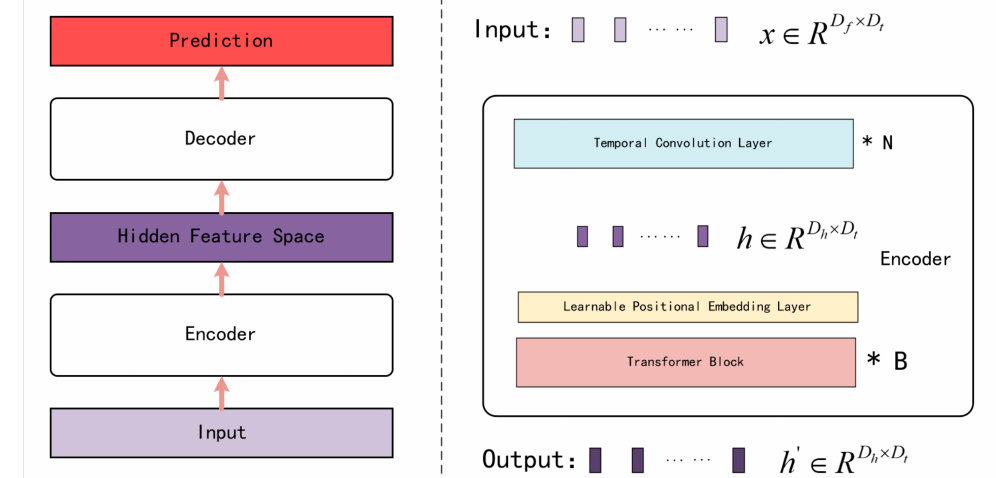
Figure 3. The structure of Auto-Encoder ( left ) and the Encoder layer of our proposal ( right ). The inner structure of the encoder is